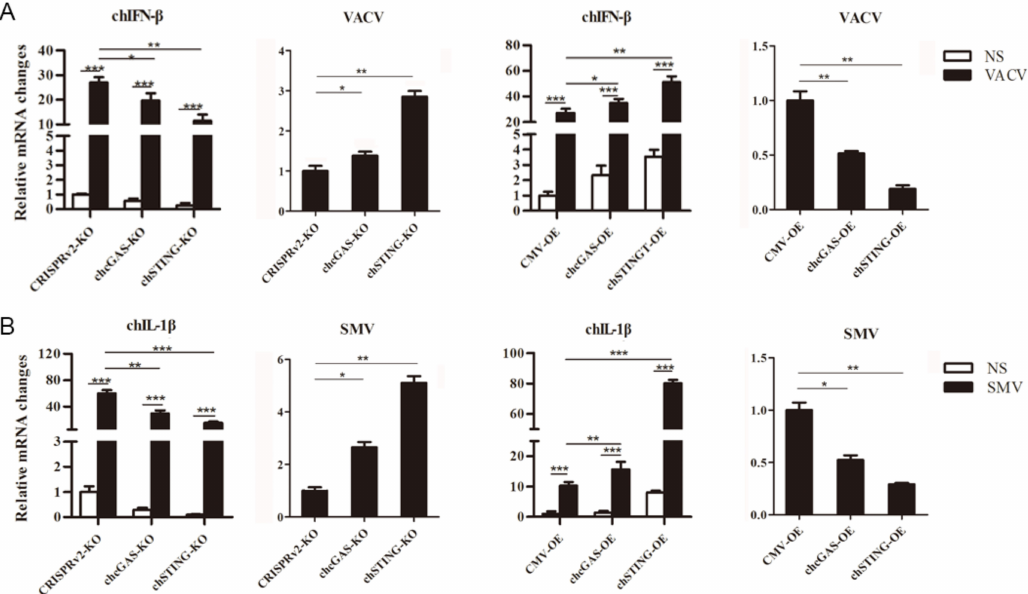
Figure 6. Vaccinia virus replications in chcGAS and chSTING stable HD11 cells. ( A ) HD11 KO and OE stable cells in 12-well plate (2 × 10 5 cells / well) were infected with VACV (0.01 MOI) for 20 h and 20 h, respectively. The cells were analyzed by RT-qPCR for both cellular gene and viral gene transcriptions. ( B ) HD11 KO and OE stable cells in 12-well plate (2 × 10 5 cells / well) were infected with SMV (0.01 MOI) for 20 h and 20 h, respectively. The cells were analyzed by RT-qPCR for both cellular gene and viral gene transcriptions. The signs “*”, “**”, “***” p < 0.05, p < 0.01 and p < 0.001,